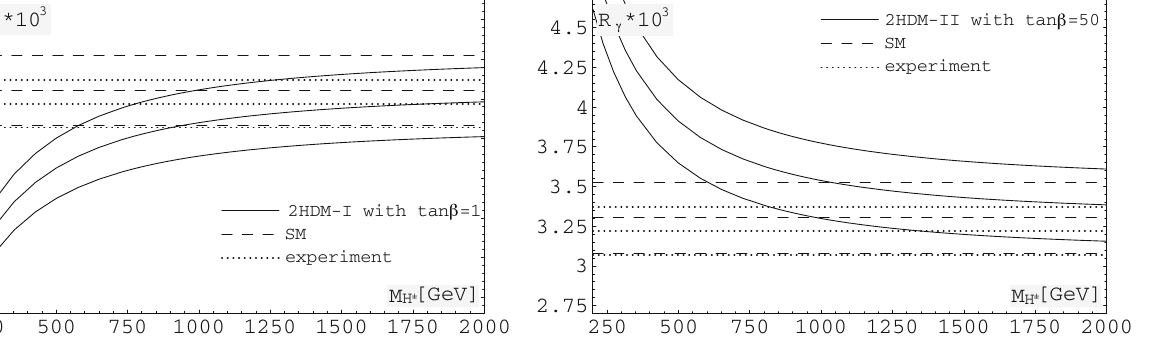
are central values with ± 1 σ shifts.) Dotted curves represent the exper- imental average. (Reprinted with kind permission from the authors, Fig. 2 of [14])